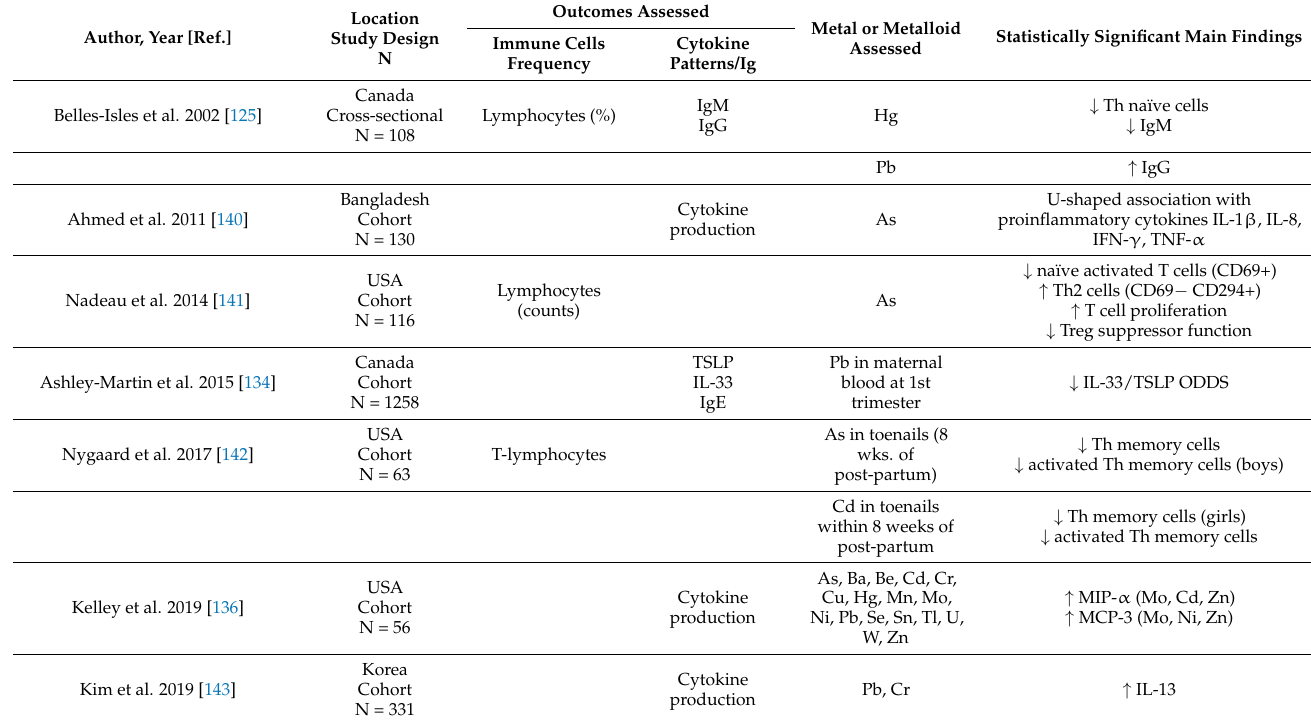
Table 6. Prenatal exposure to metals and metalloids and changes in the immune system in cord blood of neonates (authors ordered by year and then